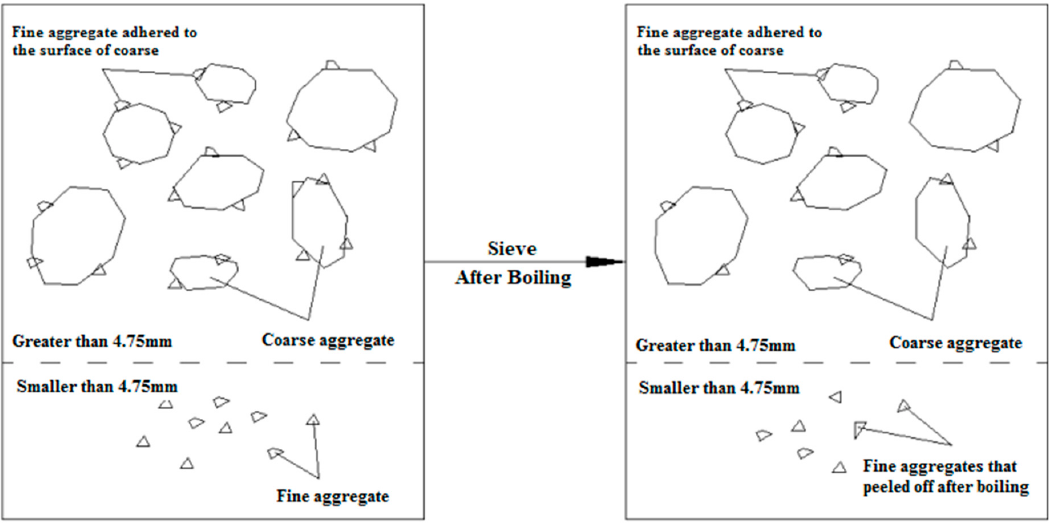
Figure 3. Schematic illustration of the boiling–sieving method.